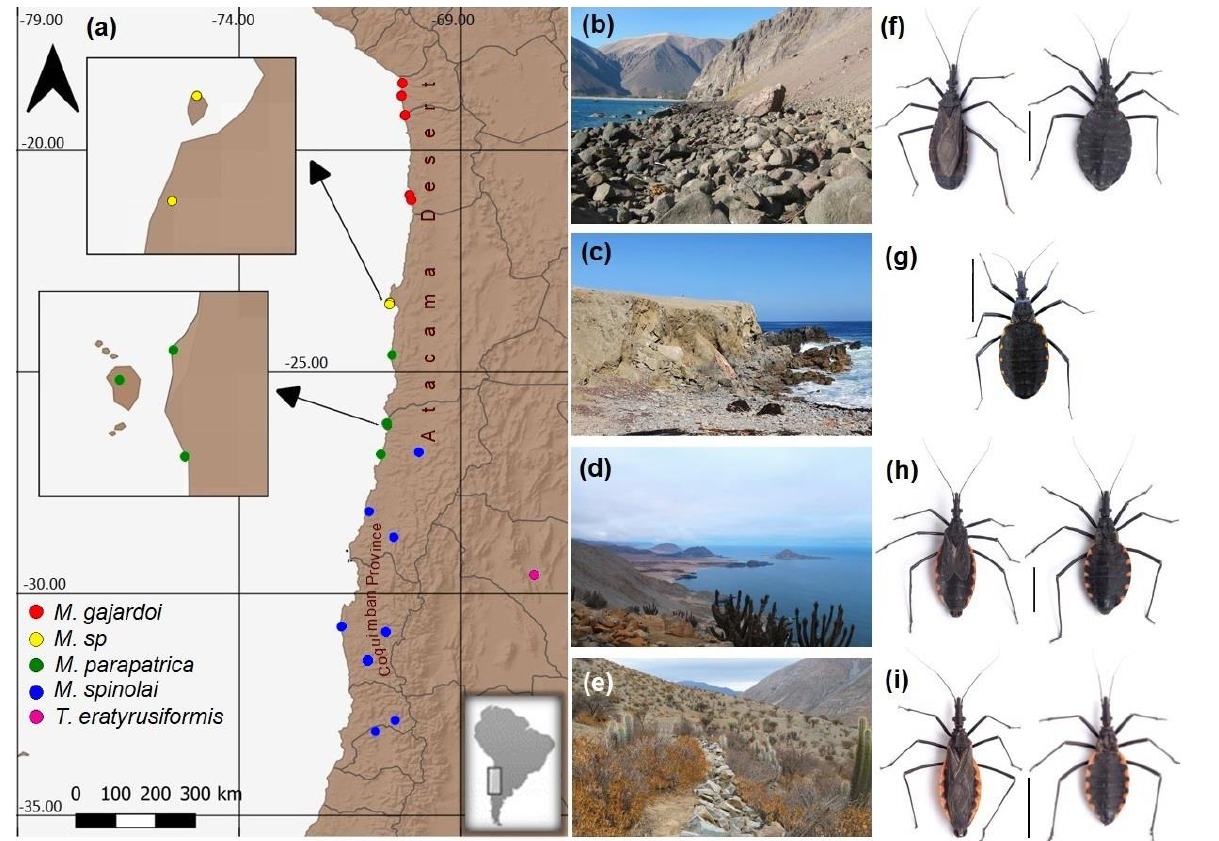
Figure 1. ( a ) Collection sites of Mepraia species with the biogeographic characteristics of the current habitats. ( b ) Sampling site of M. gajardoi in the extreme north of the coastal Atacama Desert (Caleta Vitor), photograph by Ricardo Campos-Soto. ( c ) Sampling site of M. sp. on the coast of the Mejil- lones Peninsula (Santa María Island) in the Atacama Desert, photograph by Ricardo Campos-Soto. ( d ) Habitat of M. parapatrica in the Pan de Azúcar National Park in the Atacama Desert, photograph by Ricardo Campos-Soto. ( e ) Sampling site of M. spinolai in the interior valley of central Chile in the Coquimban Biogeographical Province [17], photograph by Ricardo Campos-Soto. ( f ) Adult M. gajardoi , male on the left and female on the right, photographs by Vicente Valdés. ( g ) Female adult M. sp., photograph by Ricardo Campos-Soto ( h ) Adults of M. parapatrica , male on the left and female on the right, photographs by Vicente Valdés. ( i ) Adult M. spinolai , male on the left and female on the right, photographs by Vicente Valdés. The vertical black bar represents one centimetre.